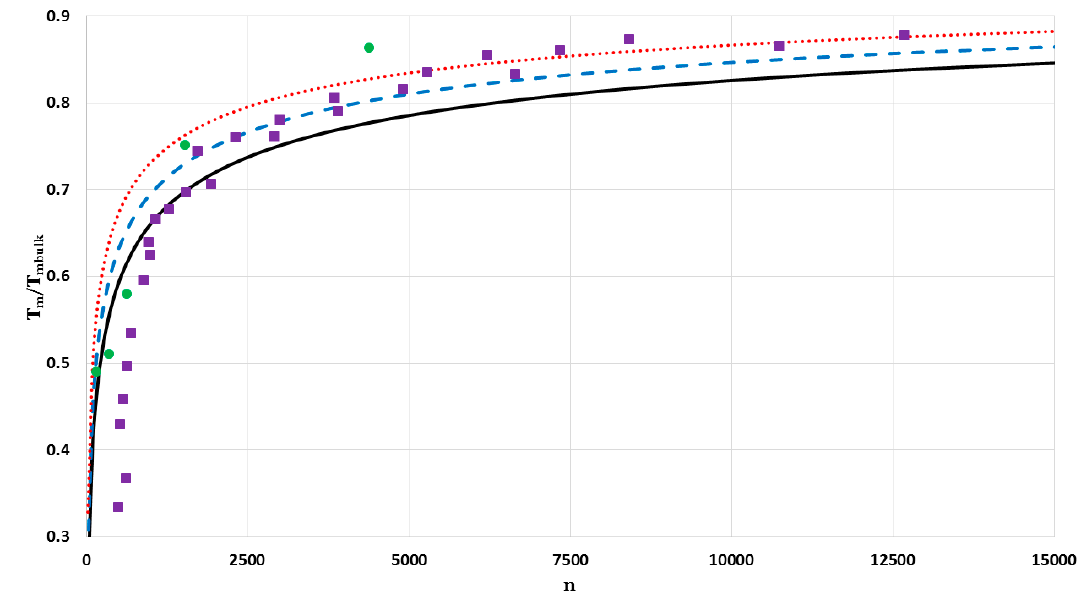
Figure 18. The variation of T m / T mbulk of nanoparticles in a face-centered cubic structure as function of Figure 18. The variation of (cid:1846) (cid:3040) (cid:1846) (cid:3040)(cid:3029)(cid:3048)(cid:3039)(cid:3038) ⁄ of nanoparticles in a face-centered cubic structure as function Figure 18. The variation of (cid:1846) (cid:3040) (cid:1846) (cid:3040)(cid:3029)(cid:3048)(cid:3039)(cid:3038) ⁄ of nanoparticles in a face-centered cubic structure as function the number of atoms for m = 3 and di ff erent values of α : 2.3 (black solid line), 2.5 (blue dashed line), of the number of atoms for (cid:1865) = 3 and different values of (cid:2009) : 2.3 (black solid line), 2.5 (blue dashed of the number of atoms for (cid:1865) = 3 and different values of (cid:2009) : 2.3 (black solid line), 2.5 (blue dashed and 2.8 (red dotted line). The first set of the experimental data [27] is denoted by purple squares and line), and 2.8 (red dotted line). The first set of the experimental data [27] is denoted by purple squares line), and 2.8 (red dotted line). The first set of the experimental data [27] is denoted by purple squares the second set of the experimental data [28] is denoted by green and the second set of the experimental data [28] is denoted by green circles. and the second set of the experimental data [28] is denoted by green circles.